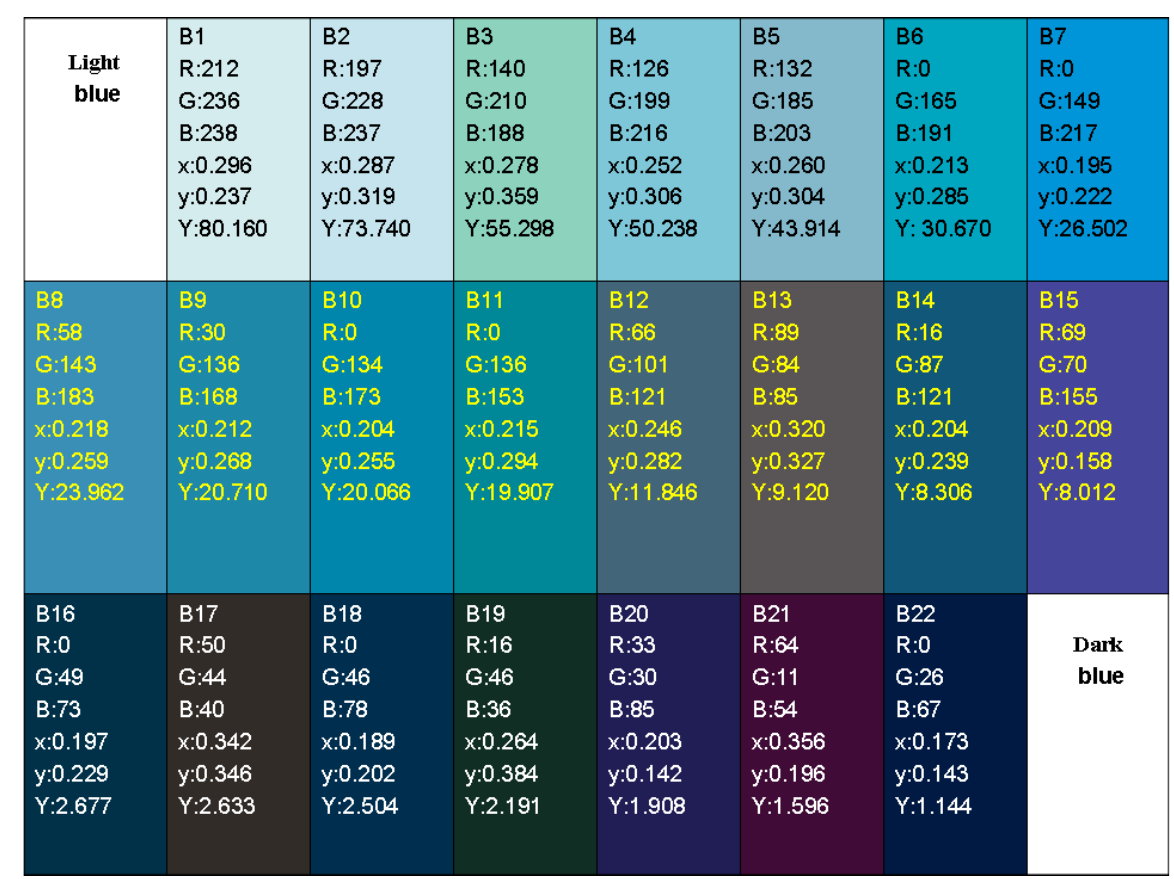
Figure 2. RGB (Red-Green-Blue) and corresponding CIE (Commission internationale de l ’ éclairage) chromaticity coordinates — CIE (x, y) and Luminance (cd/m 2 ) Y data of 22 shades of blue dye, in- cluding 7 shades of light blue (B1 – B7), 8 shades of medium blue (B8 – B15) and 7 shades of dark blue (B16 – B22). CIE (x, y, Y) based on Siljak [49 ] “ColorHexa— Color encyclopedia: Information and con- version”: http://www.colorhexa.com/.(accessed on 7 August 2018) Table 1. RGB, CIE (x, y, Y) and colour ratio of 7 blue dye